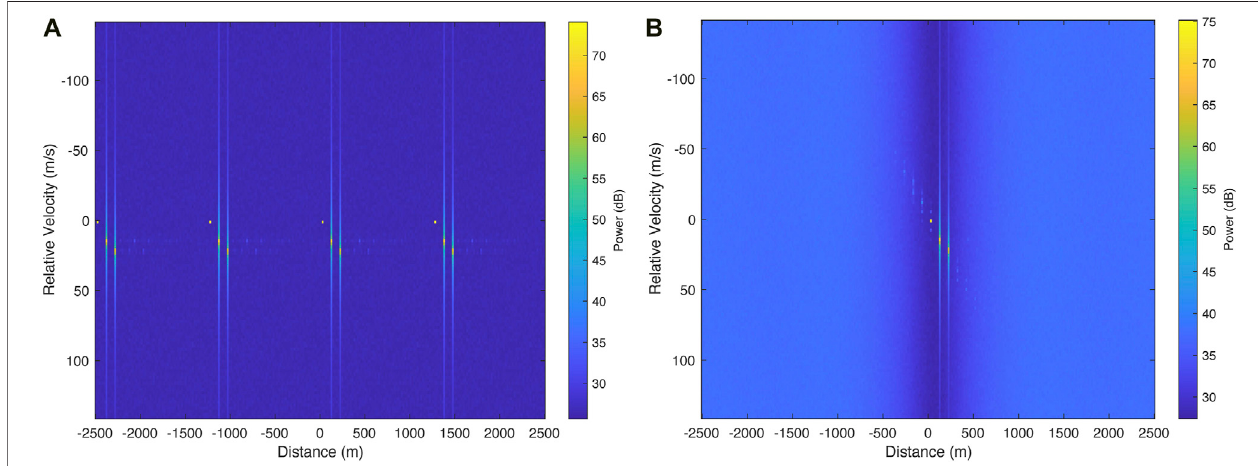
FIGURE 4 | Distance – velocity plot of the three targets with velocities [0, 14.9, 21.2] (m/s) and distances [29.3, 127.3, 225.3] (m) where SNR is 10 dB. (A) Comb- type pilot-based OFDM and (B) proposed OFDM-IM JCR scheme.